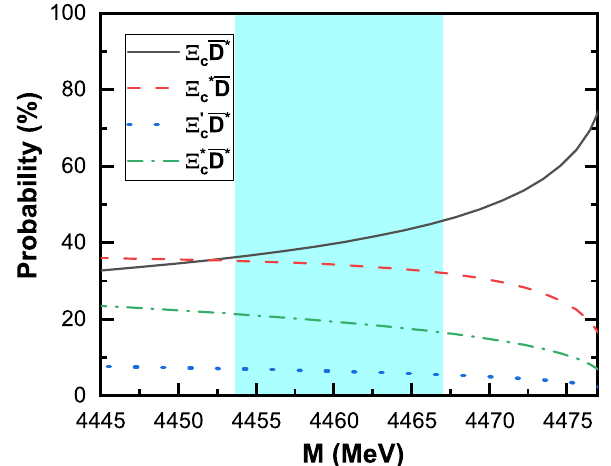
Fig. 3 Probabilities for different channels of the P cs ( 4459 ) as a cou- pled (cid:2) c ¯ D ∗ /(cid:2) ∗ c ¯ D /(cid:2) (cid:3) c ¯ D ∗ /(cid:2) ∗ c ¯ D ∗ moleculewith I ( J P ) = 0 ( 3 / 2 − ) .The shallow area labels the position of the P cs ( 4459 ) including the experi- mental